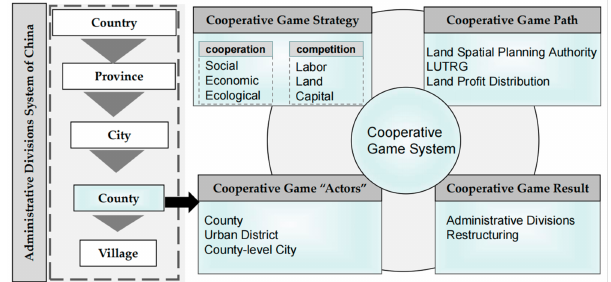
Figure 1. The theoretical